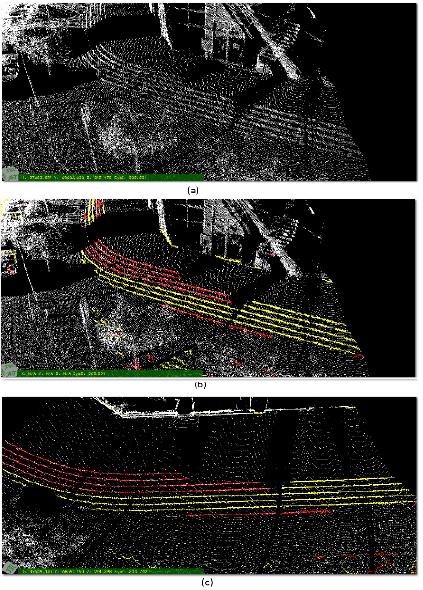
Figure 6. Extraction of steps.